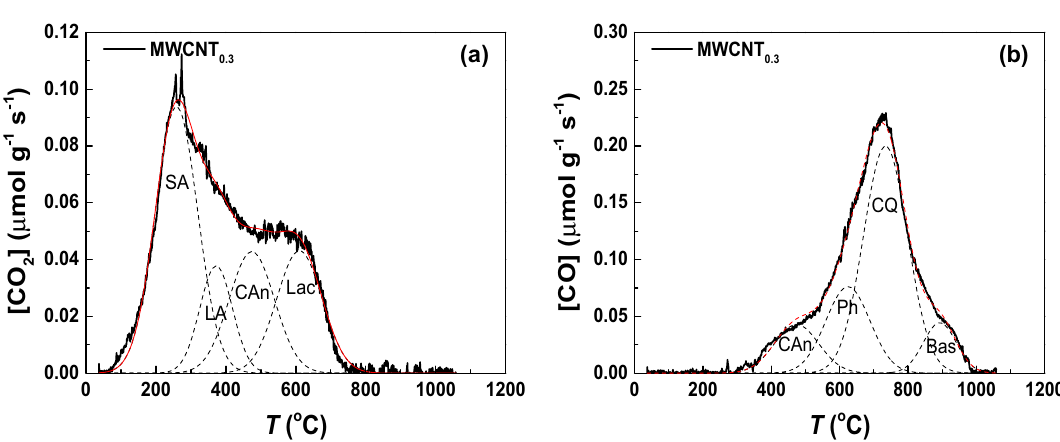
Figure 3. (a) Amounts of CO 2 ( SD ≤ 39 μmol g −1 ) and CO ( SD ≤ 48 μmol g −1 ) released by TPD and (b) contents of oxygen ( SD ≤ 0.19 wt%) and volatiles ( SD ≤ 0.49 wt%) as function of the concentration of HNO 3 employed in the hydrothermal treatment of MWCNTs. Points represent experimental data, while lines represent non-linear fittings.